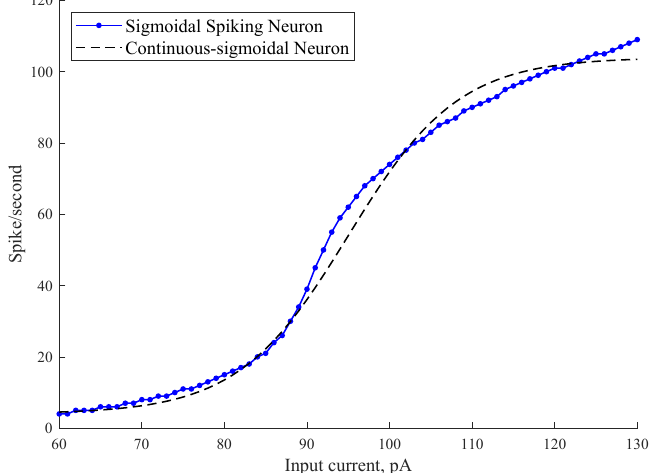
Figure 2. Response of spiking neuron in sigmoidal configuration (Nonlinear